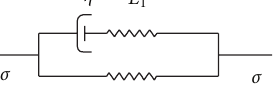
Figure 3: The generalized Maxwell viscoelastic model for PP wood